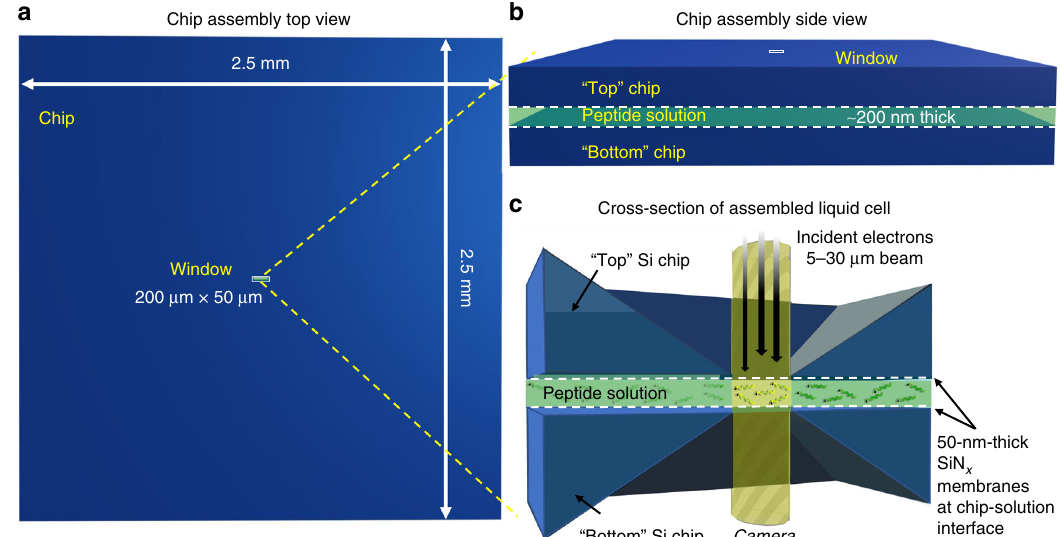
Fig. 1 Liquid cell transmission electron microscopy (LCTEM) experimental setup. a Top view of a silicon nitride (SiN x ) chip with an electron-transparent window of 200 µ m× 50 µ m. b Side view of two chips (top and bottom) assembled as a liquid cell containing a peptide sample solution, with a liquid thickness of ~200 nm. c Cross-section of an assembled liquid cell, placed in the tip of an LCTEM holder, where the windows of each chip are overlapping for imaging. The SiN x fi lm in this case is 50 nm